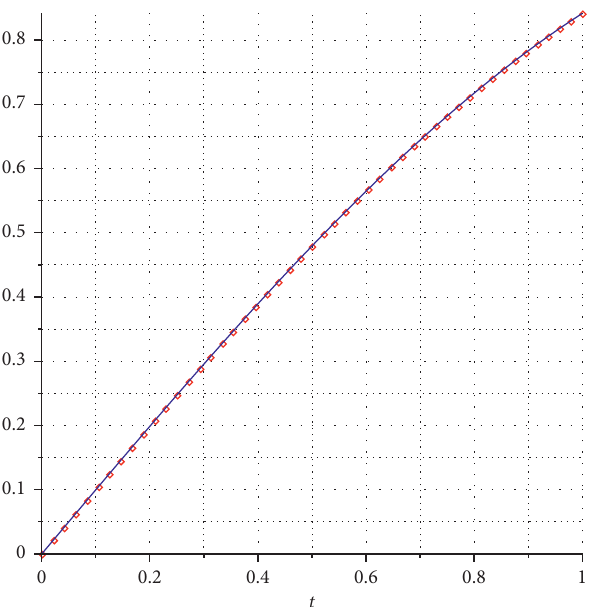
Figure 1: Comparison of the exact solution (blue) and the ap- proximate solutions (red) of Example